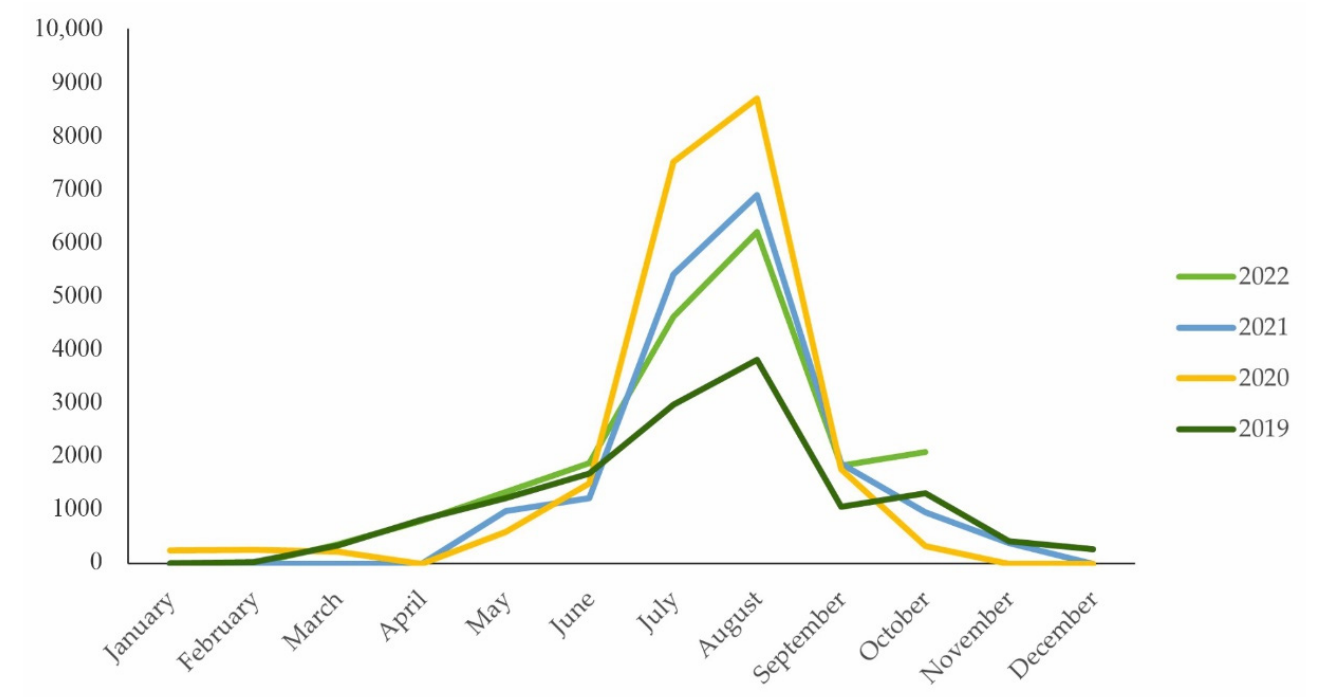
Figure 9. Monthly visits of the Jozef adit in years 2019 to 2022 (based on internal data from Dubnik Opal Mines). Table 4. Geosites near the Dubnik Opal Mines.